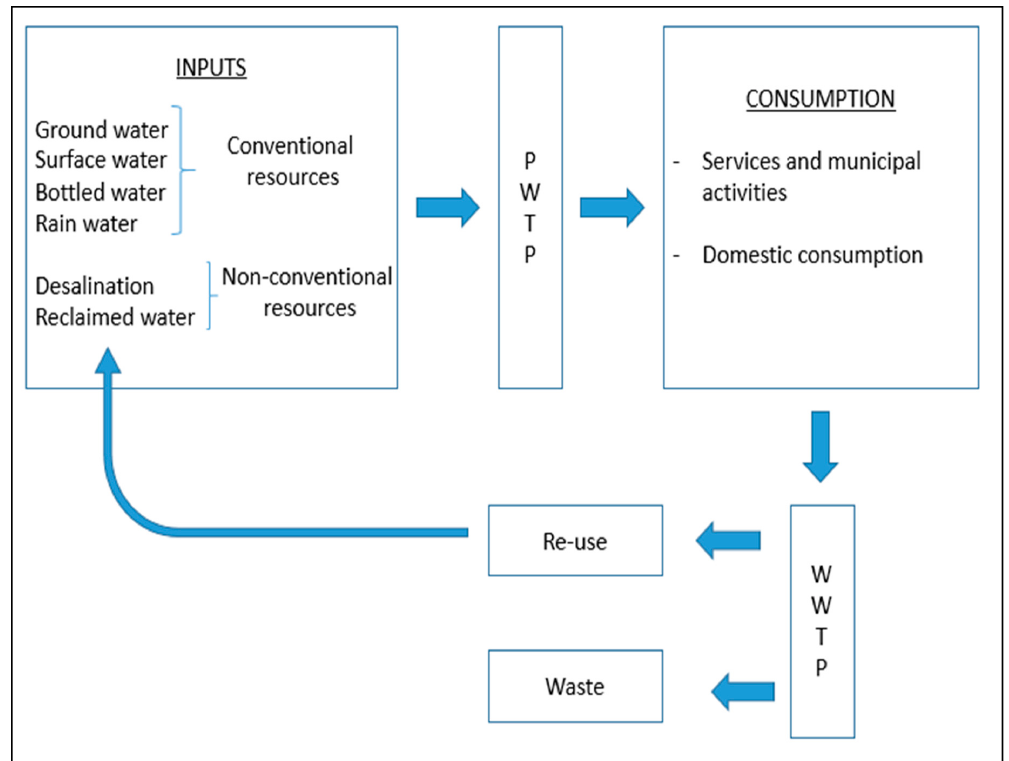
Figure 2. Model to create urban flow diagrams. Compiled by the author.